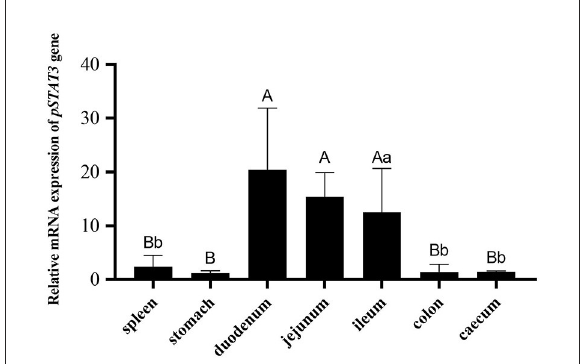
FIGURE1 The mRNA expression of porcine STAT3 in the tissues of the 28-day SPF piglets ( n = 3). The tissues expression data was analyzed by one-way ANOVA. Different capital letter indicated significant difference ( P < 0.01); different lowercase letter indicated significant difference ( P < 0.05). Data are presented as means ±